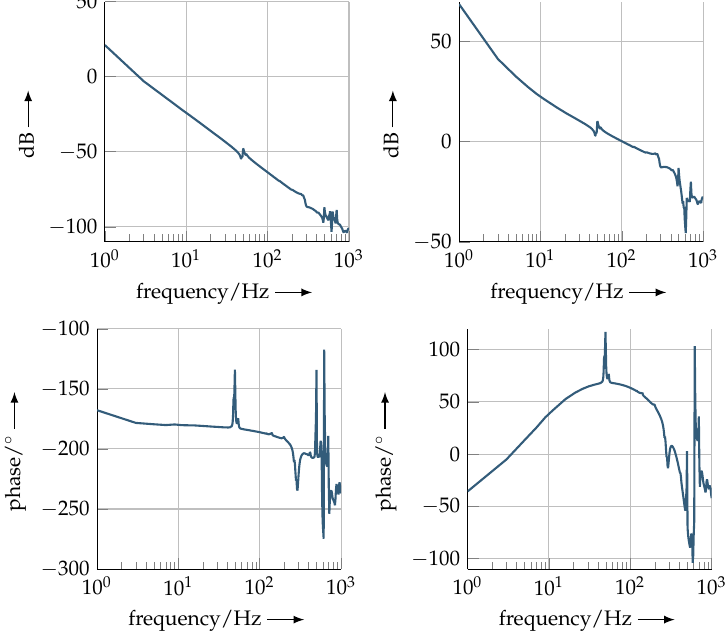
Figure 6. Comparison of the reconstructed transfer function of the plant alone (diagrams in the left half) and the open loop, including the controller (diagrams in the right half). The diagrams show the amplitude responses in decibels in the upper row and the phase responses in the lower row.